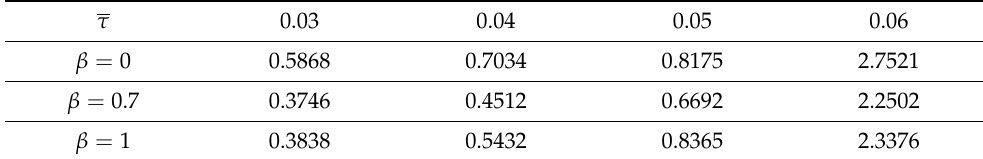
Table 5. Minimum γ for various of τ and β values in Case 2.